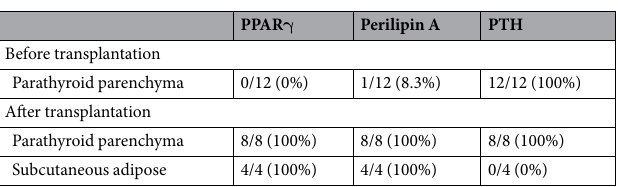
Table 3. Expression of adipocyte markers in transplants before and after transplantation. Expression of adipocyte markers, PPAR γ and perilipin A, and PTH was examined in transplants by immunohistochemistry before transplantation and one to three-and-half months after transplantation. Shown are the number of specimens with expression over the number of specimens examined and the percentages of specimens with expression in parentheses. Transplants were parathyroid parenchyma and subcutaneous adipose from three SHPT